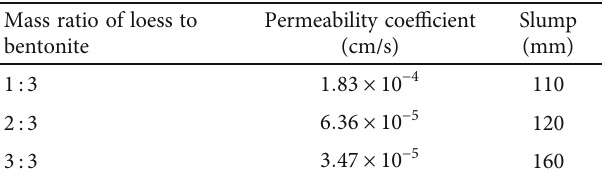
Figure 6: (a) Relation curve of the slurry injection ratio and the permeability coe ffi cient. (b) Relation curve of the slurry injection ratio and the slump. Table 2: Test results for improving gravel sand with bentonite and loess mixed